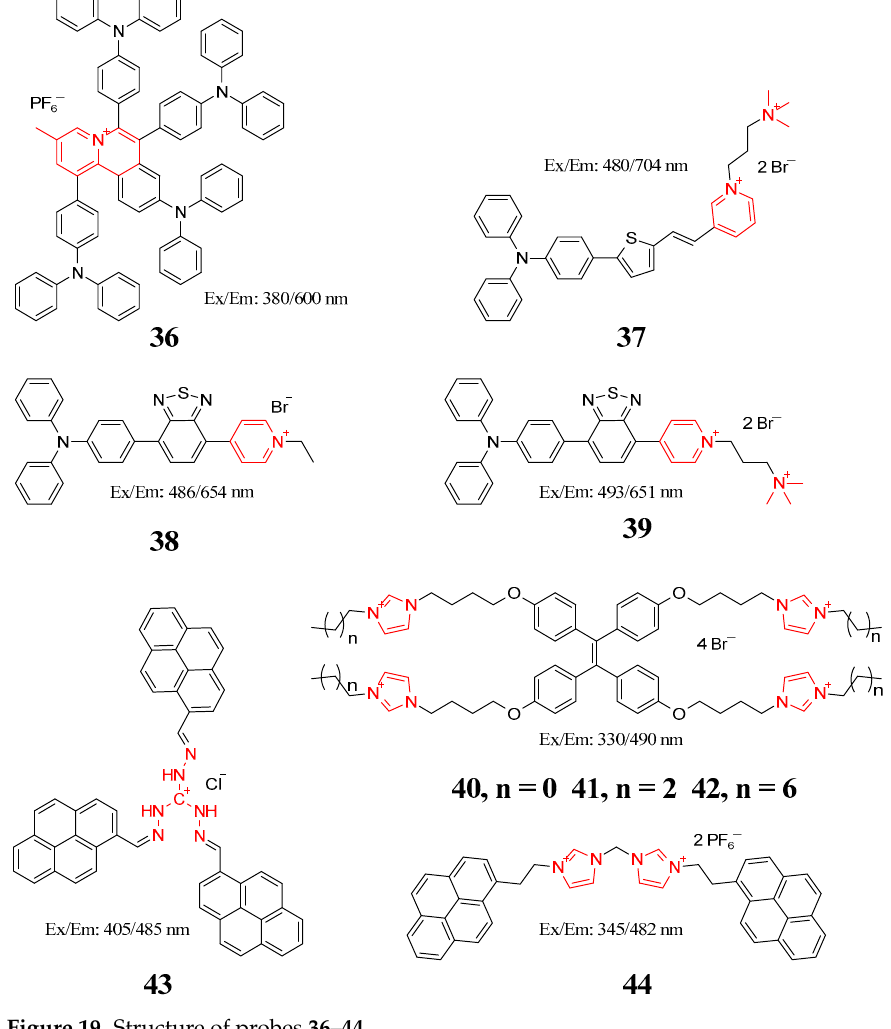
Figure 19. Structure of probes 36 – 44